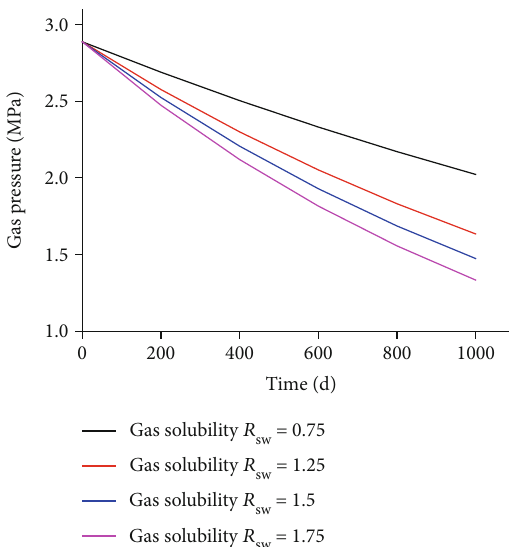
Figure 5: E ff ect of gas solubility on pressure change.